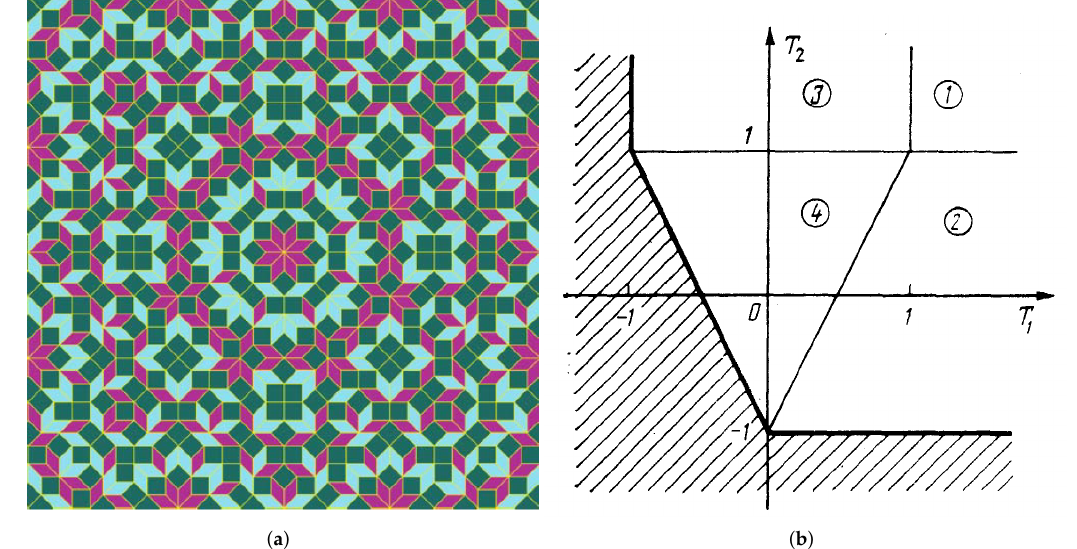
Figure 6. ( a ) The shape of the octagonal quasiperiodic pattern, reprinted with permissions from Ref. [103]. ( b ) The stability chart for patterns composed of four amplitudes, A 1,2,3,4 , in the plane of nonlinearity coefficients, T 1 and T 2 , of Equation (101), reprinted with permissions from Ref. [9]. Stability areas of the rolls (103), squares (104), rectangles (105), and octagonal quasicrystal (106) are denoted by encircled numbers 1, 2, 3, and 4, respectively.